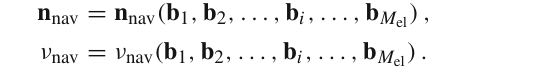
Fig. 8 Navigator tune enhancement coefficients k x and k y versus the beam momentum in the NICA collider for protons functions of its introduced magnetic